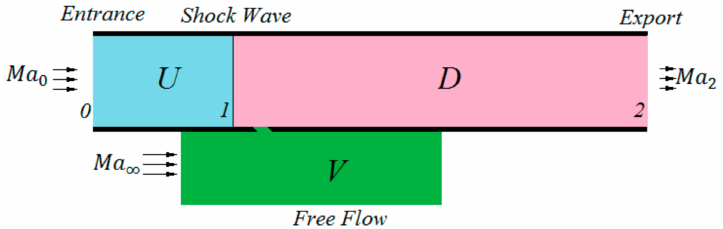
Figure 3. Shock wave motion calculation